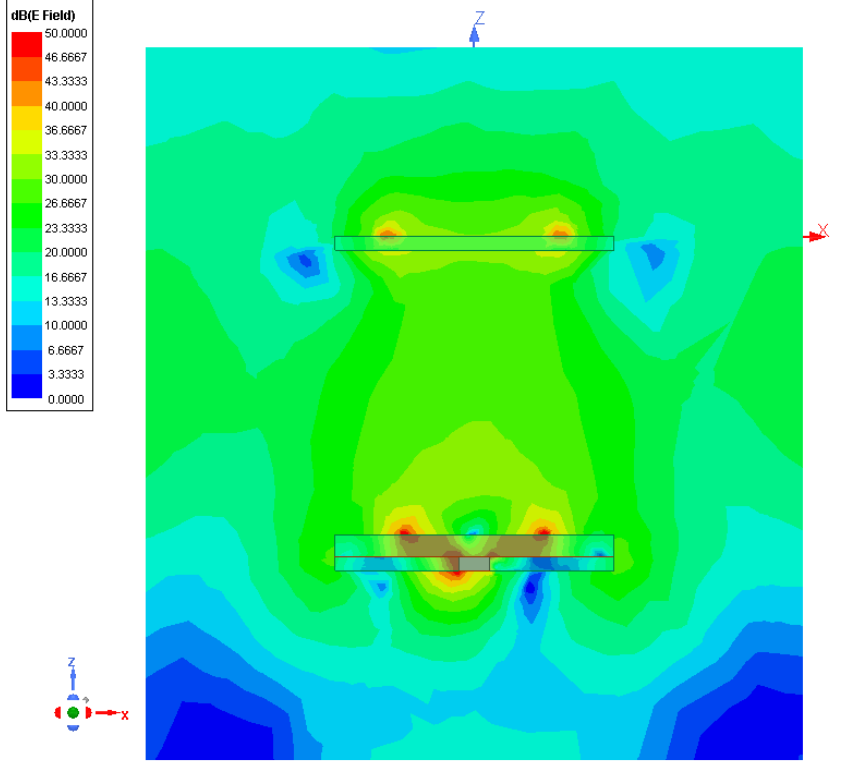
Figure 6. Numerical assessment ( [ f min , f max ] = [ 2.3, 2.6 ] [GHz], f = f 0 = 2.45 [GHz])—2D map of the magnitude of the electric field, | E ( x , z ) | , in a vertical surface parallel to the ( x , z ) -plane and crossing the center of the WWCS